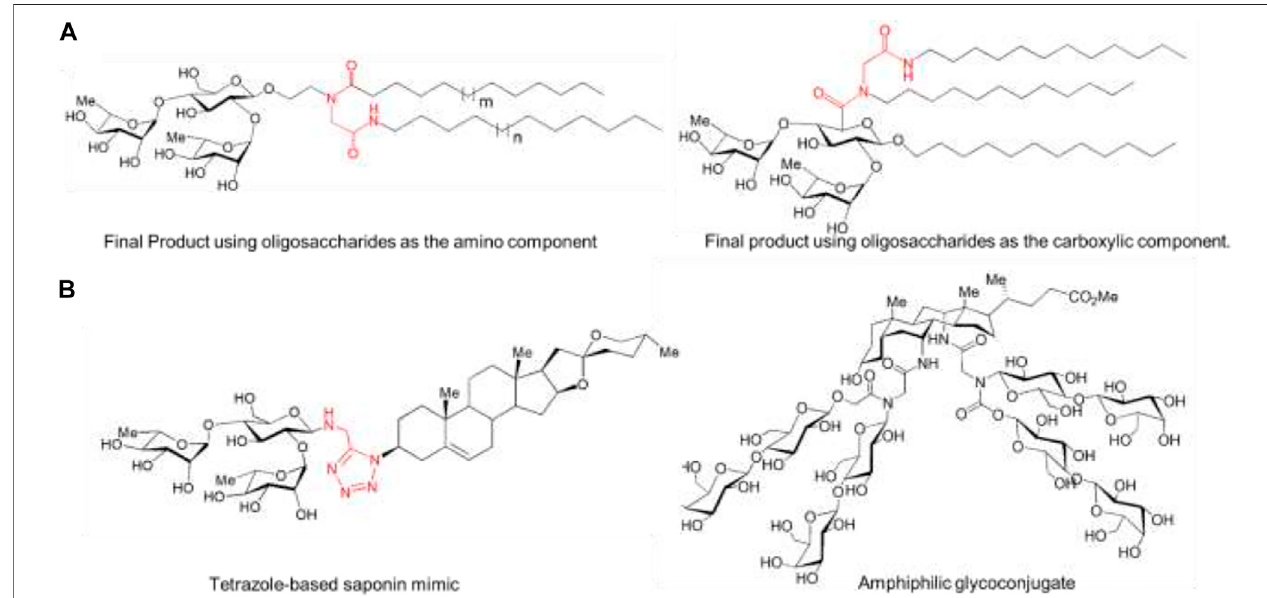
FIGURE 9 | (A) Lipid-Lipid and lipid-oligosaccharide conjugates. (B) Oligosaccharide-steroid conjugates: Steroid-carbohydrate conjugates by multicomponent conjugation (MCC) of oligosaccharide to steroidal isocyanides. The most important covalent bond between entities is highlighted in